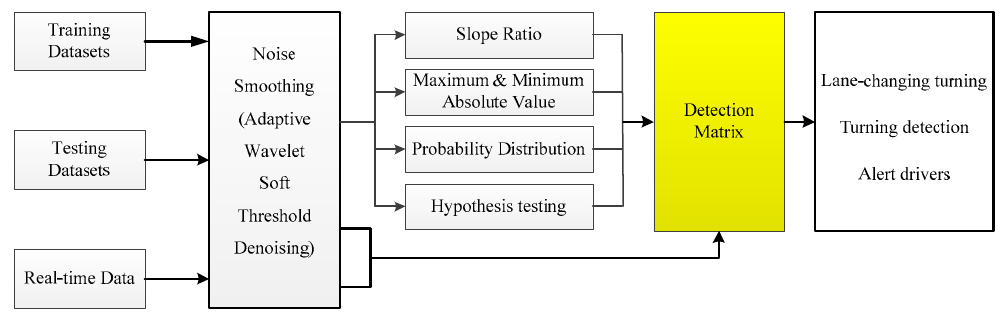
Figure 5. Real-time detecting matrix.